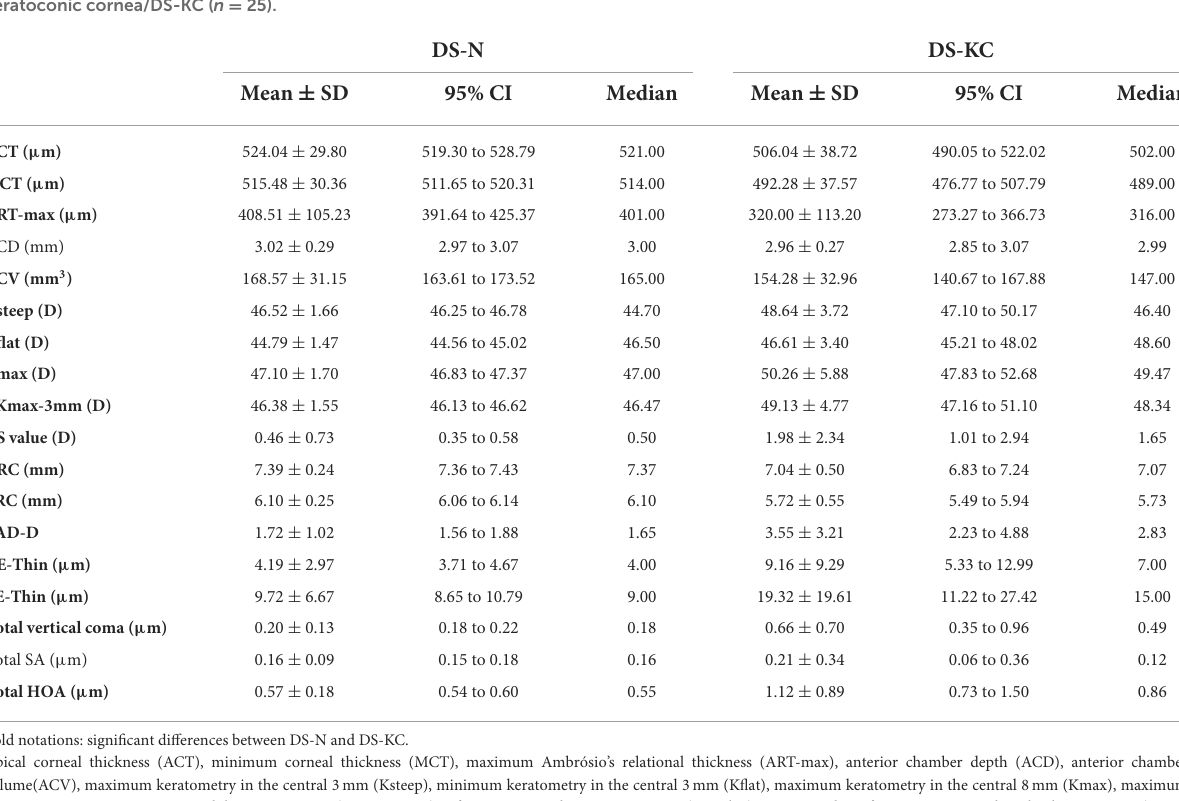
TABLE 1 Distribution of corneal indices in Down syndrome patients with normal cornea/DS-N ( n = 154) and Down syndrome patients with keratoconic cornea/DS-KC ( n =